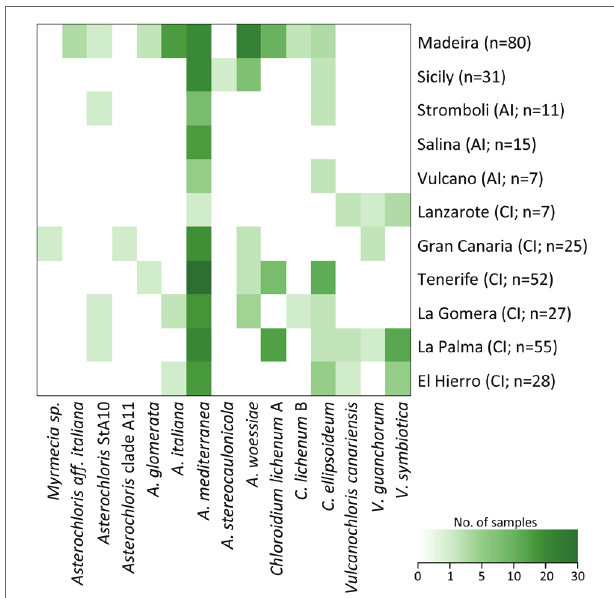
FIGURE 5 | Distribution of phycobiont species-level lineages on particular islands within the study area. Number of samples is indicated in brackets. AI, Aeolian Islands and CI, Canary